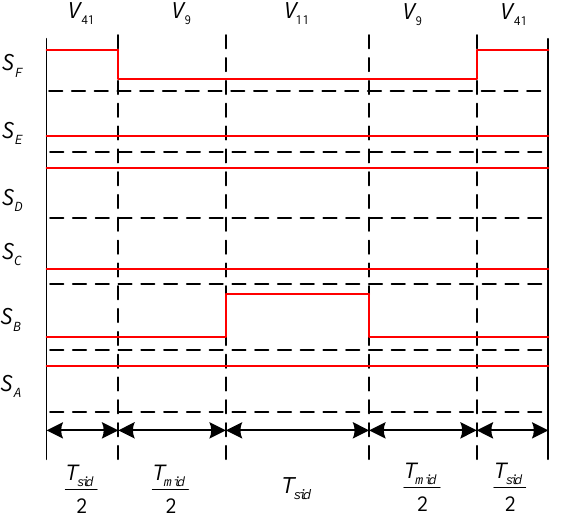
Figure 14. Switching sequence when M 1 reduces switching frequency synthesis.